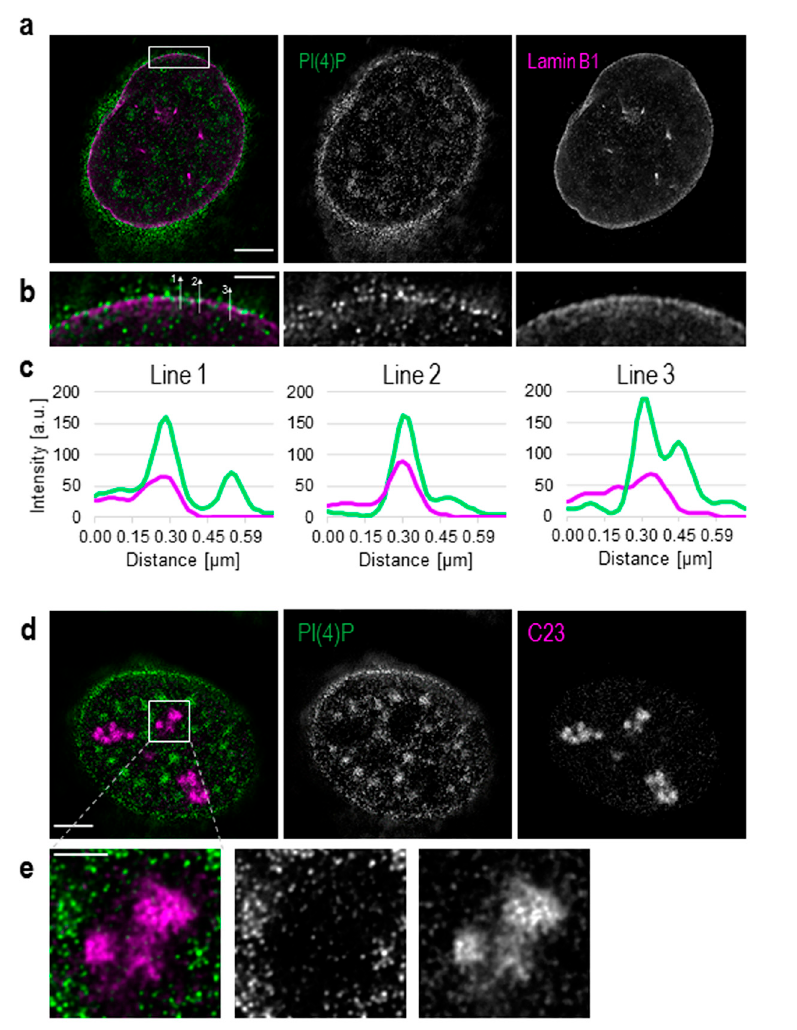
Figure 1. Detection of phosphatidylinositol 4-phosphate (PI(4)P) at the nuclear envelope and in the nucleoli. Super-resolution STED microscopy revealed the localisation of PI(4)P in the nuclear lamina, the nucleoli, nuclear speckles and nucleoplasmic foci. ( a ) Fluorescently labelled PI(4)P and lamin B1. ( b ) PI(4)P co-localises with lamin B1. ( c ) Intensities of pixels along the lines in b , PI(4)P (green) and lamin B1 (purple). Lines are drawn in a direction from the nucleoplasm to the cytoplasm (from bottom to top). Graphs were made using the FiJi software. ( d ) Localisation of PI(4)P and a protein C23, a marker of the nucleoli. ( e ) PI(4)P localises to the nucleoli, but the intensity of PI(4)P staining is much lower than in the nucleoplasm. Scale bars: a—5 μ m; b—1 μ m; d—5 μ m; e—2 μ m.